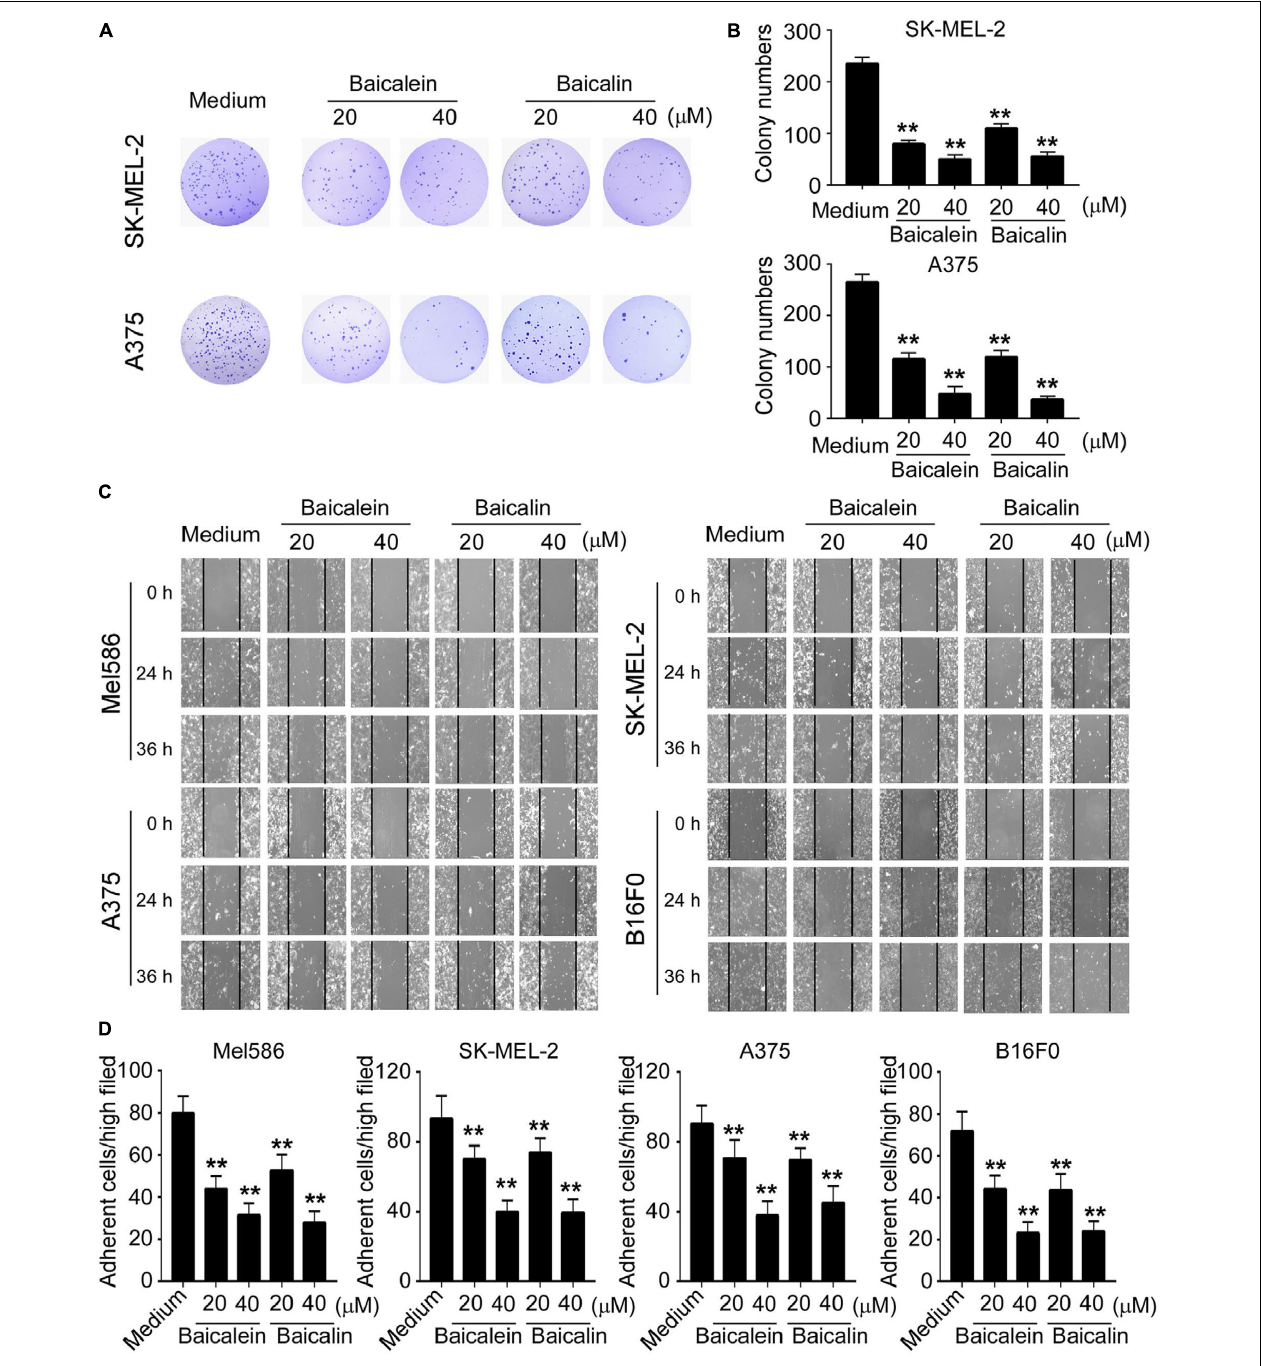
FIGURE 2 | Baicalein and baicalin inhibit melanoma cell colony formation, migration and adhesion. (A,B) Baicalein and baicalin treatments dramatically decreased the numbers and sizes of tumor colonies in SK-MEL-2 and A375 cells. 200–500 per well of melanoma cells pre-treated with the indicated concentrations of baicalein or baicalin, were seeded in 6-well plates for culture, and cell colonies counted after 10–14 days of culture. Results shown in the histogram (B) are summaries of mean ± SD from three independent experiments. ** p < 0.01 compared with the medium control group. (C) Different concentrations of baicalein and baicalin treatments in both human and mouse melanoma cells significantly inhibited tumor cell migration compared with the medium control group at 24 and 36 h time points in the wound closure assays. Data shown are representatives from three independent experiments with similar results. (D) Baicalein and baicalin treatments suppressed the adhesion of melanoma cells. Both human and mouse melanoma cells pretreated with the indicated concentrations of baicalein and baicalin were cultured in the fibronectin-coated plates for 45 min. Adherent cells were counted and averaged in 10 fields at high ( × 400) magnification with a microscope. Results shown are summaries of mean ± SD from three independent experiments with similar results ** p < 0.01 compared with the medium control group.